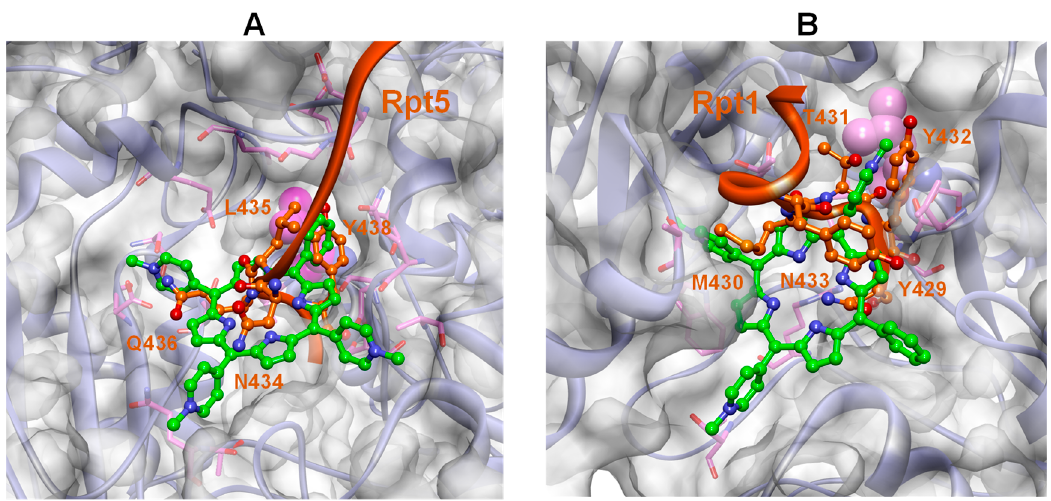
Figure 12. Structural overlap of the 19S C-terminal tails (i.e., Rpt5 and Rpt1) with Tris-T4 obtained by fitting the C α atoms of the 20S α -ring of the Tris-T4 / h20S best-docked complex (three ligand molecules; h20S starting conformation: closed) on the C α atoms of the 20S α -ring of the h26S structure (ED 2 , open state; PDB ID: 6MSK). ( A ) Tris-T4 bound at the α 5– α 6 groove (green) and the Rpt5 C-terminal (orange) of 19S. ( B ) Tris-T4 bound at the α 4– α 5 groove (green) and the Rpt1 C-terminus (orange). The Rpt C-terminal residues overlapping with Tris-T4 are displayed in ball&stick and labelled. For sake of clarity, only the h20S structure of the docked complex is displayed. Residues interacting with both Tris-T4 and the Rpt residues are displayed in stick and coloured in pink. The vdW volume of L77 ( α 6; A) and L81 ( α 5; B) is shown in